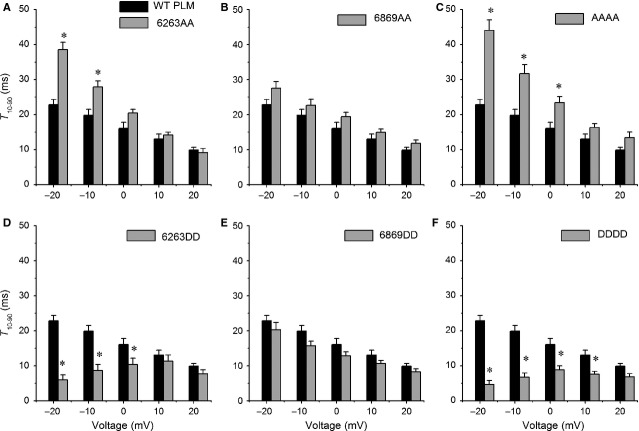
S62S63 phosphorylation affects the PLM-induced CaV1.2 activation slowdown. T10-90, the time required to activate from 10% to 90% of the peak currents, was measured from the currents elicited during 300-msec. steps ranging from −20 to +20 mV (10-mV increments, representative currents are depicted in Fig.2). (A) T10-90 for 6263AA (grey, n + 7) was significantly larger than WT PLM (dark, n + 10) at −20 and −10 mV, P < 0.05. (B) T10-90 for 6869AA (grey, n + 6) was larger than WT PLM without significant differences at any observed voltages, P > 0.05. (C) T10-90 for AAAA (grey, n + 7) was significantly larger than WT PLM at −20, −10 and 0 mV, P < 0.05. (D) T10-90 for 6263DD (grey, n + 8) was significantly smaller than WT PLM at −20 and 0 mV, P < 0.05. (E) T10-90 for 6869DD (grey, n + 6) was smaller than WT PLM, without any significant differences at the observed voltages, P > 0.05. (F) T10-90 for DDDD (grey, n + 7) was significantly smaller than WT PLM at −20 to +10 mV, P < 0.05. *P < 0.05 versusWT PLM.